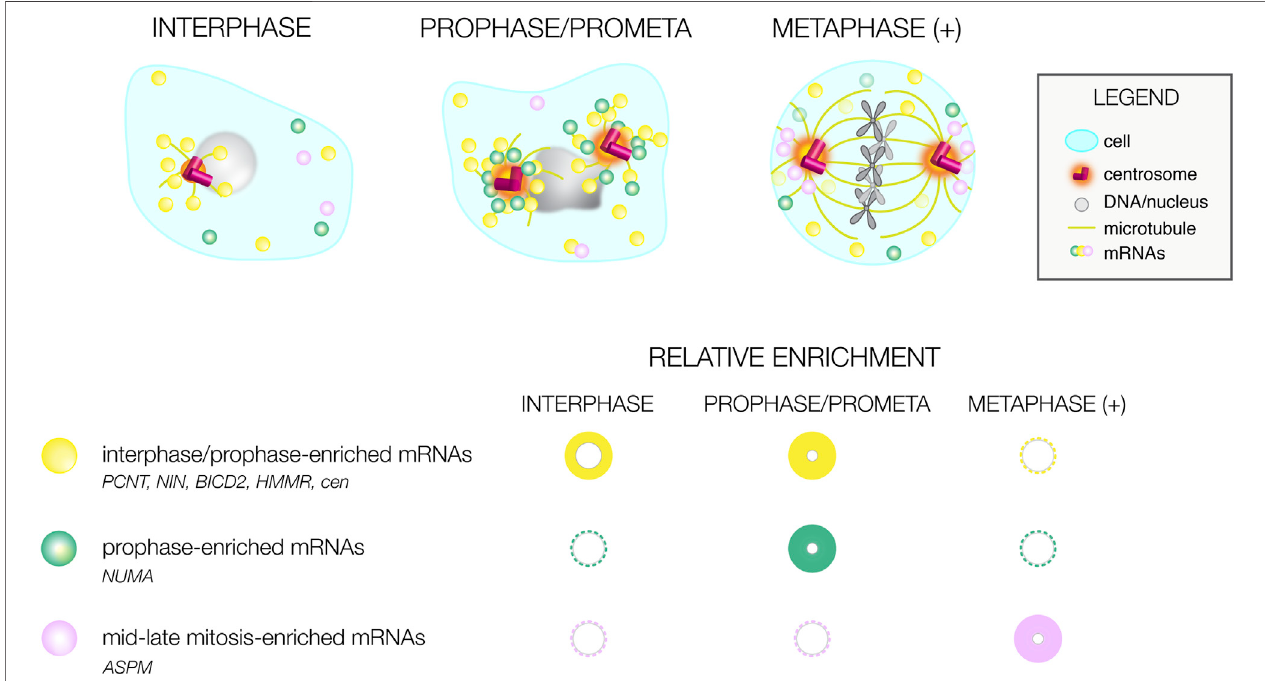
FIGURE 2 | Cell cycle-dependent variances in mRNA distributions. Illustration of differential mRNA distributions of conserved centrosome-enriched mRNAs during interphase,prophase,andmetaphase-to-latemitosis(metaphase(+)).Below,agraphicalsummaryofmRNAdistributionsatthesamecellcyclestagesasreportedby(Sepulveda et al., 2018; Ryder et al., 2020; Sa fi eddine et al., 2021). The size and intensity of the circle correlates with the prevalence of mRNA localization; representative mRNAs are listed.